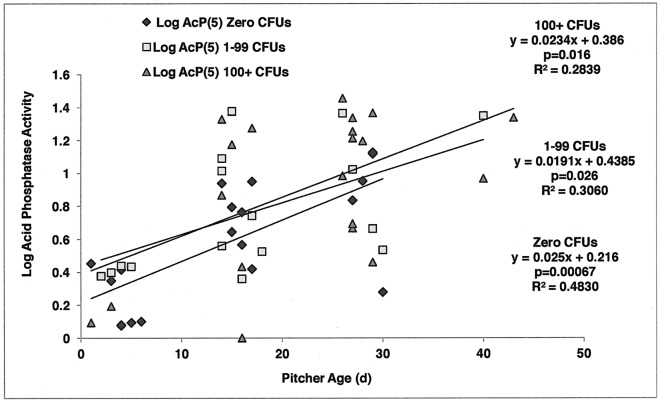
Regression analysis of log acid phosphatase activity on Day 5 across pitcher age (d) for fed pitchers separated on the basis of microbe levels on Day 5 (Microbes(5)), taken from samples of pitcher fluid.Enzyme activity increased with pitcher age in all three microbe levels. The amount of variation explained by pitcher age (R2) decreased with increasing microbe levels.